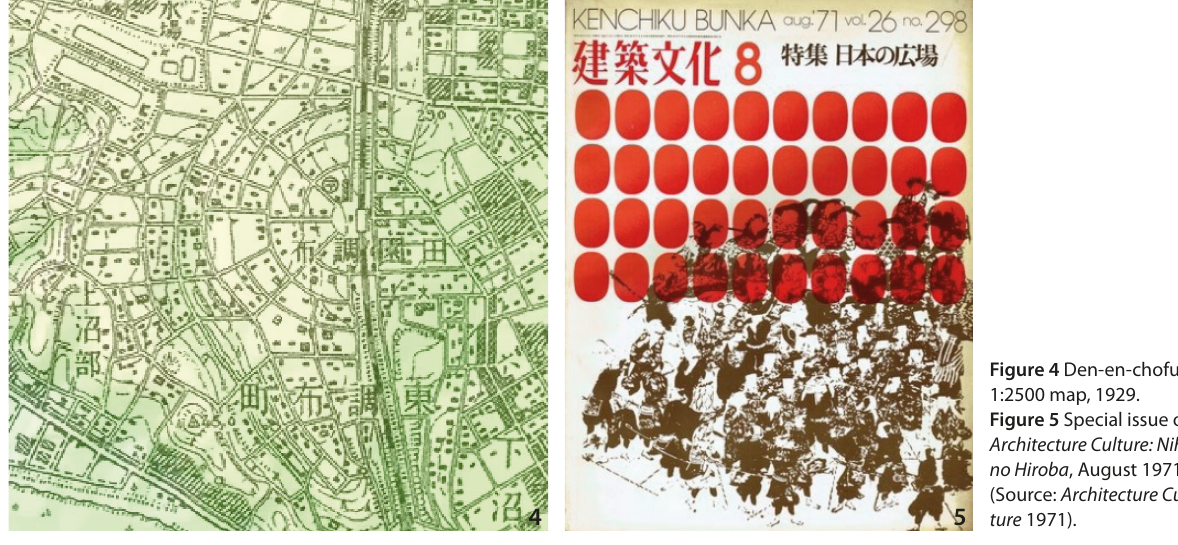
Figure 4 Den-en-chofu 1:2500 map, 1929. Figure 5 Special issue of Architecture Culture: